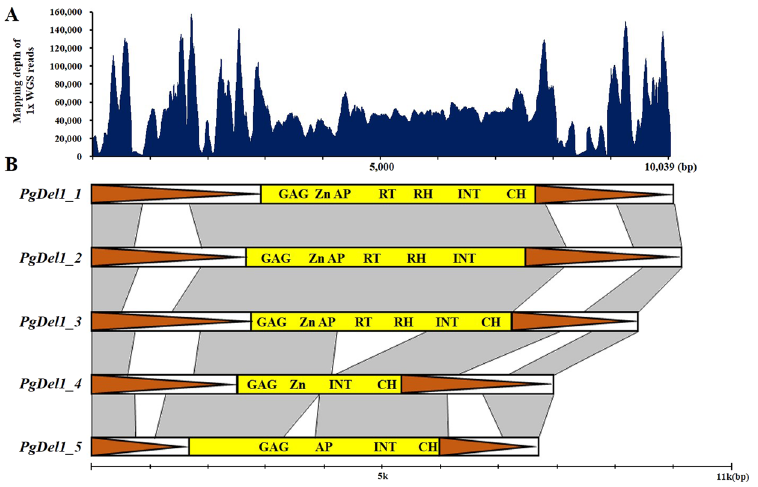
Figure 2. Structural characteristic of five PgDel1 subfamily members. ( A ) Representation of the distribution of 1x WGS data of P . ginseng cv. CP. (B) Horizontal schematic diagrams of PgDel1 subfamily members 1–5. Boxed orange triangles indicate LTR regions of PgDel1 . Yellow boxes indicate the internal LTR-RTs domains of PgDel1 detected in each subfamily member. (AP: aspartic protease, CH: chromodomain, GAG: capsid protein, INT: integrase, RH: RNase H, RT: reverse-transcriptase, and Zn: zinc knuckle). Homologous sequence were indicated as grey panels.